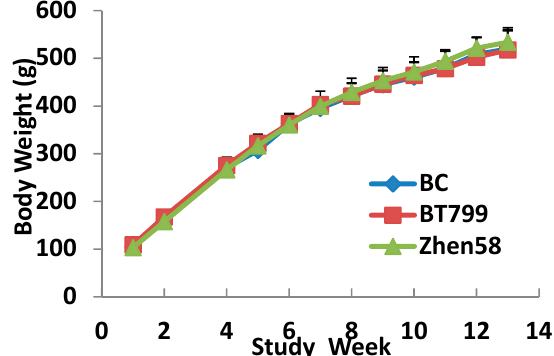
Figure 1. Mean body weights. Values are presented as mean ± SD, analysed by ANOVA, and followed by least-significant difference or Dennett’s multiple comparisons for post-hoc comparison between multiple groups.